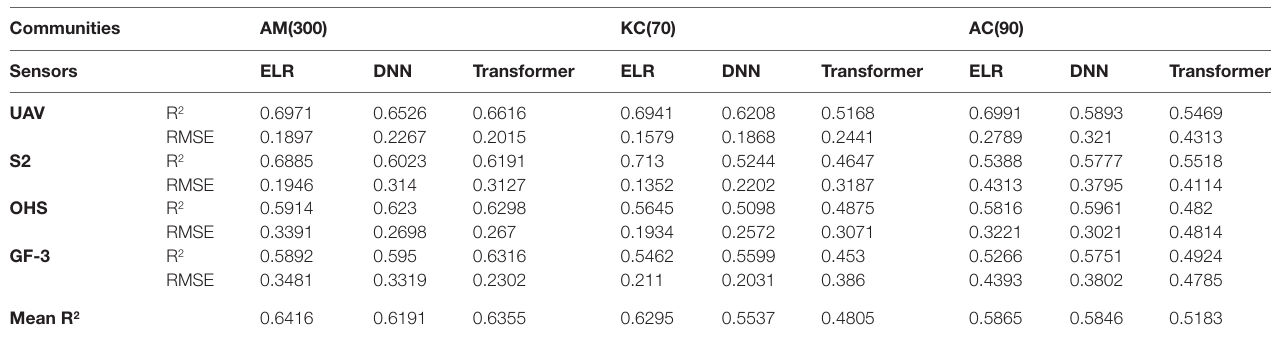
TABLE 5 | The LAI estimation accuracy of mangrove communities using the ELR and DLR models.